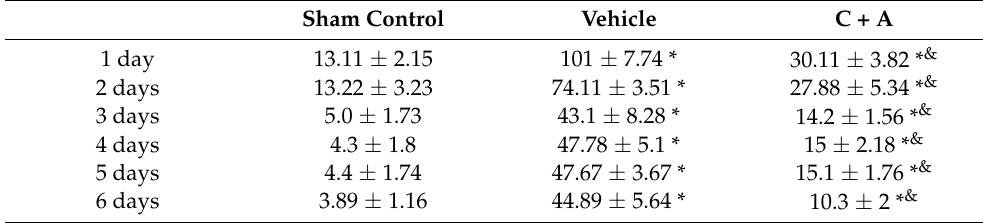
Table 1. The escape latency of three experimental groups in the positioning navigation